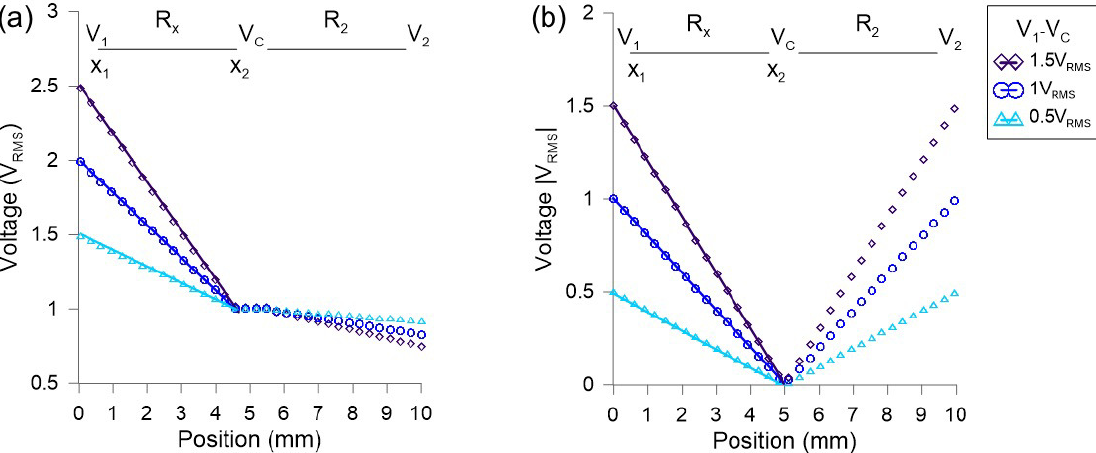
Figure 6. Simulation of the voltage distribution along the transmission line for ( a ) voltage divider configuration and ( b ) orthogonal configuration. Dots are the numerical calculations and lines the results of Equation (5). Structural parameters can be found in References